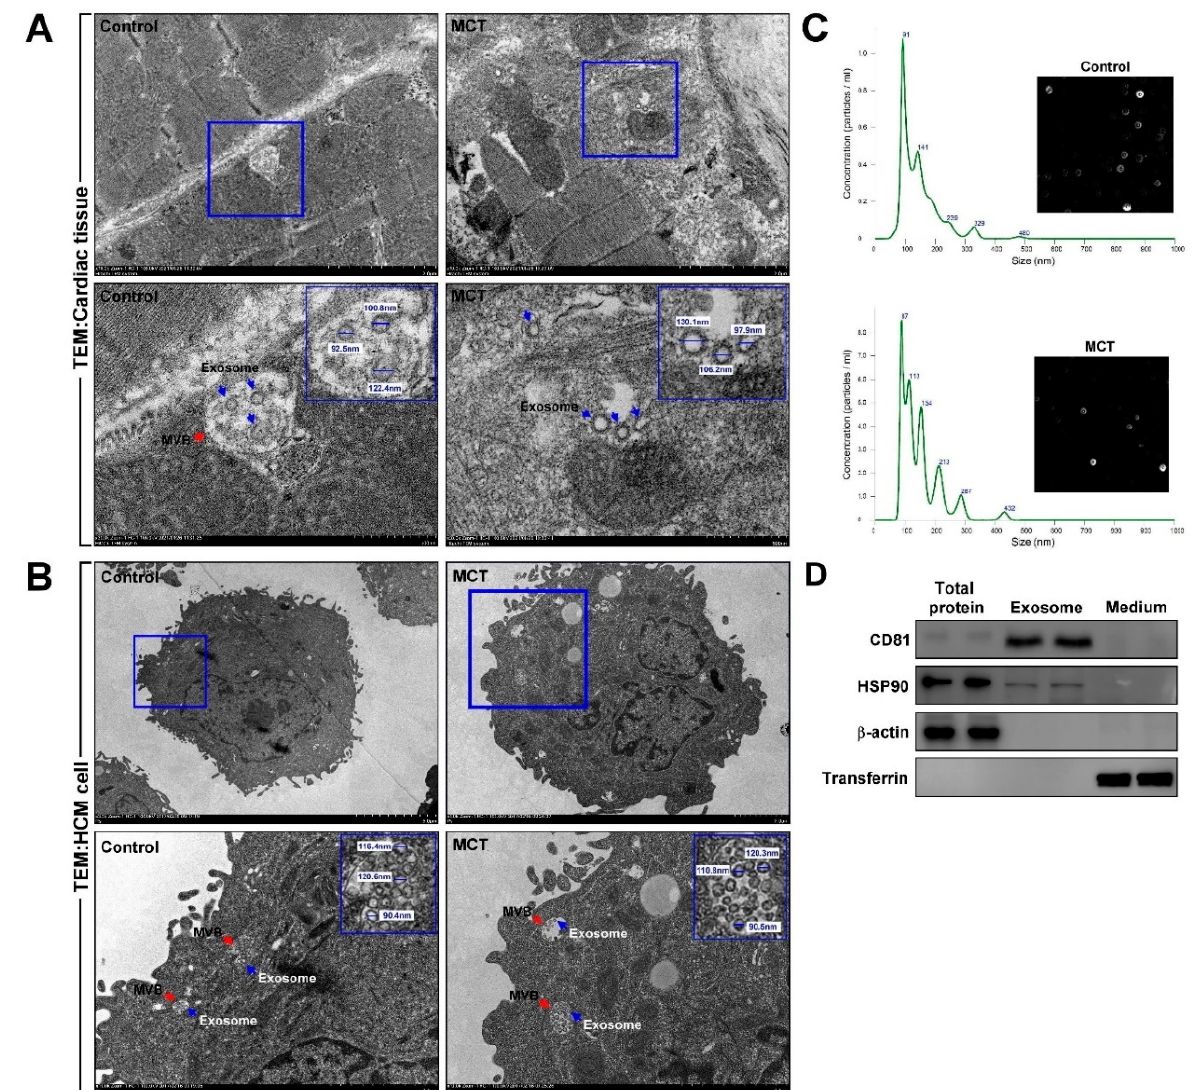
Figure 3. Cardiomyocyte-derived exosomes were detected in vitro and in vivo. ( A , B ) Multivesicular body (MVB) and exosome presence in myocardial tissue and human cardiomyocytes (HCM) were examined and quantified using TEM and Image J software. MVB, red arrow; exosome, blue arrow. ( C ) HCMs were treated with or without MCT for 24 h, and then the secreted exosomes were isolated from the culture medium. The exosome size was measured by nanoparticle tracking analysis. ( D ) The expression of exosomal proteins CD81 and HSP90 was examined by western blotting analysis. Data are representative of three independent experiments ( n = 3).